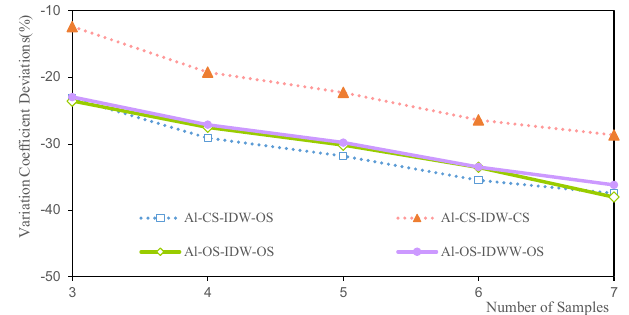
Figure 16. Deviation of the variation coefficient of the Al grade.